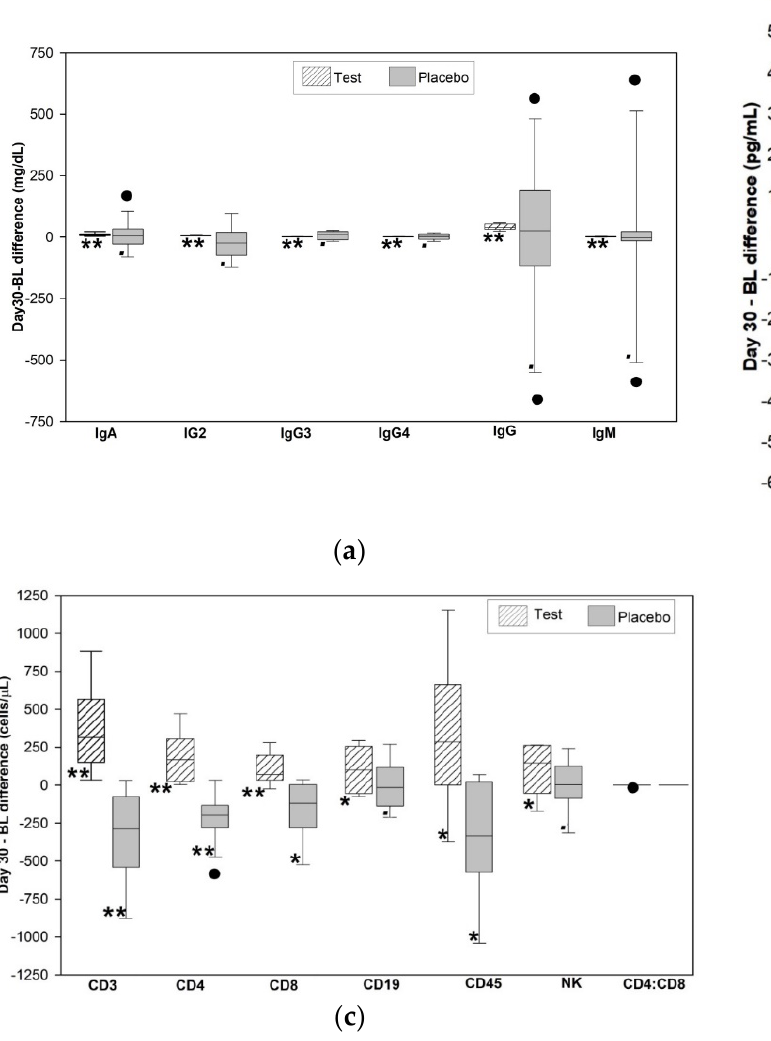
Figure 2. Box plot of the difference between the day 30 and baseline (BL, day0) in participants treated with test (WS) and placebo. ( a ) Comparison of immunoglobulin level (mg/dL) in serum ( n = 12/group) for the study period (day 0–30) ( b ) Comparison of mean difference (bias) and confidence intervals for the bias of cytokine level (pg/mL) in serum ( n = 12/group) for the study period (day 0–30). ( c ) Comparison of mean difference (bias) and confidence intervals for the bias of T cells (CD3+ CD4+, CD8+), B cells (CD19+), CD45+, and NK absolute cell counts (cells/µL) in whole blood ( n = 12/group) for the study period (day 0–30). * Significant at p < 0.05. ** Significant at p < 0.01. • Not significant ( p > 0.05).